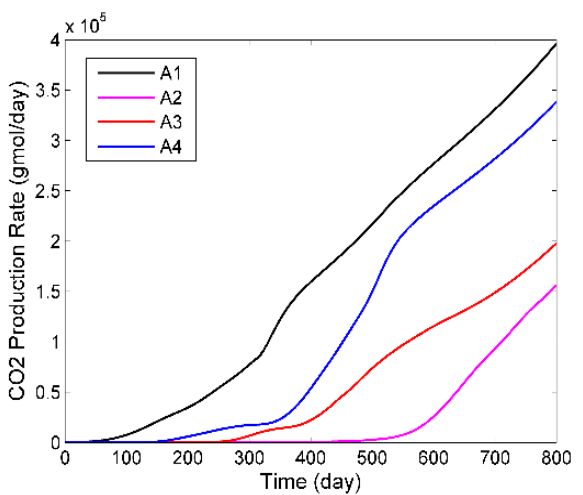
Figure 16. CH 4 production rates for well pattern A.